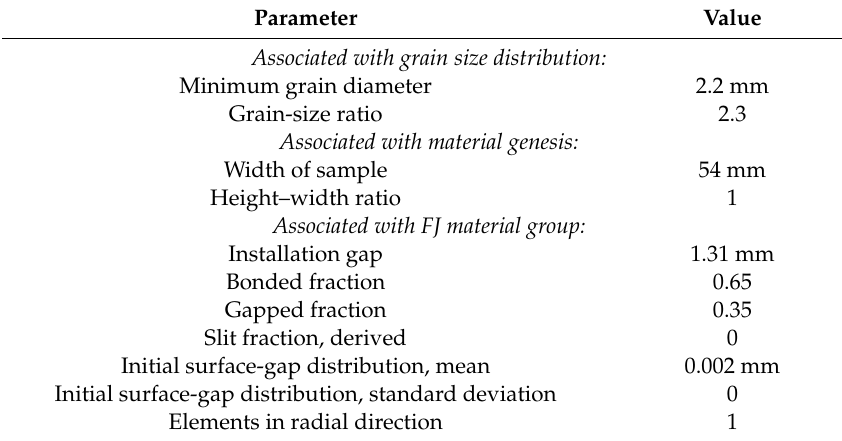
Table 1. List of microparameters obtained after calibration for the numerical rock sample. Parameters required for grain and material genesis are also listed